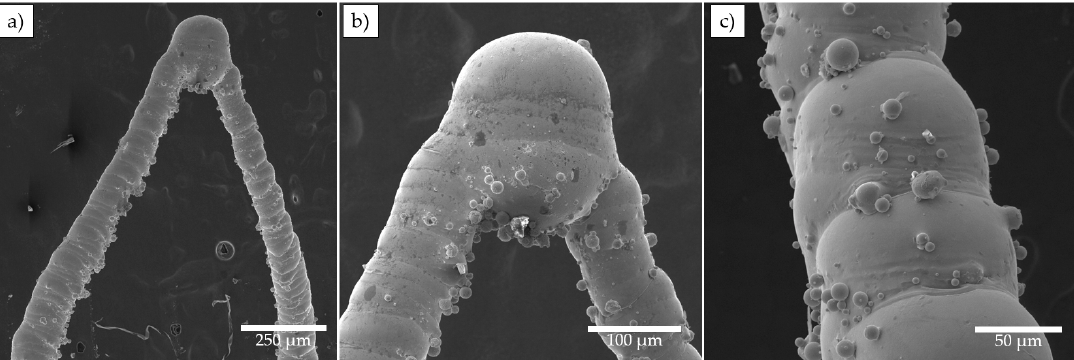
Figure 11. High magnification images of 3D-printed SAF sample P100V850: ( a ) the upper part, ( b ) the tip, ( c ) the strut of upper part.